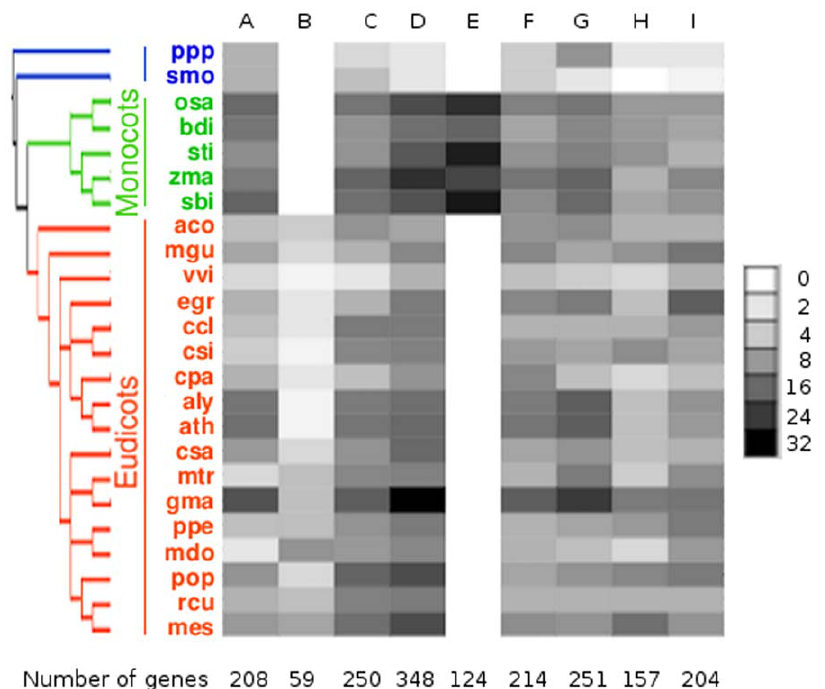
Figure 4. Distribution of ATLs from 24 plant species in 9 groups. Heat map representation of the number of ATLs from the 24 species in each one of the nine groups by a gray scale. The total number of genes in each group is shown at the bottom (the distribution of the 1815 ATLs in 9 groups in displayed in Table S2). The species tree is as in Figure 1. doi:10.1371/journal.pone.0023934.g004 (the display of the 75 sequence LOGOs is shown in Table S3). The region for which the greatest number of LOGOs was obtained was region VII, corresponding to the carboxyl-end of the protein; this is the region most diverse in size (see Figure 2B). Nineteen se-